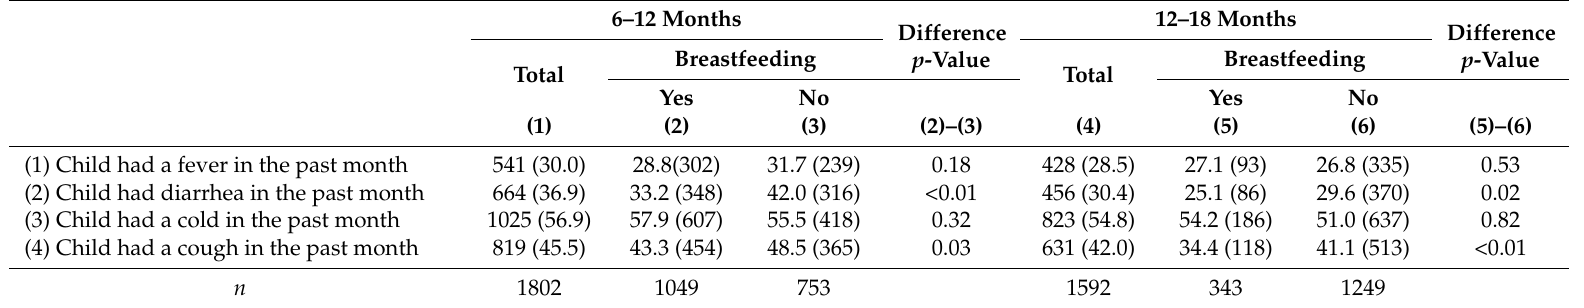
Table 4. Correlation between breastfeeding and health outcomes in children aged 6–18 months in rural China ( n =